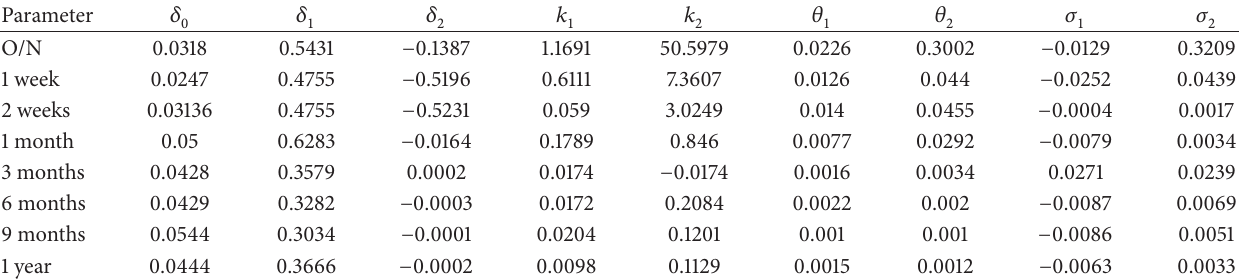
Table 3: The parameter estimation results of the SHIBOR two-factor Vasicek model.